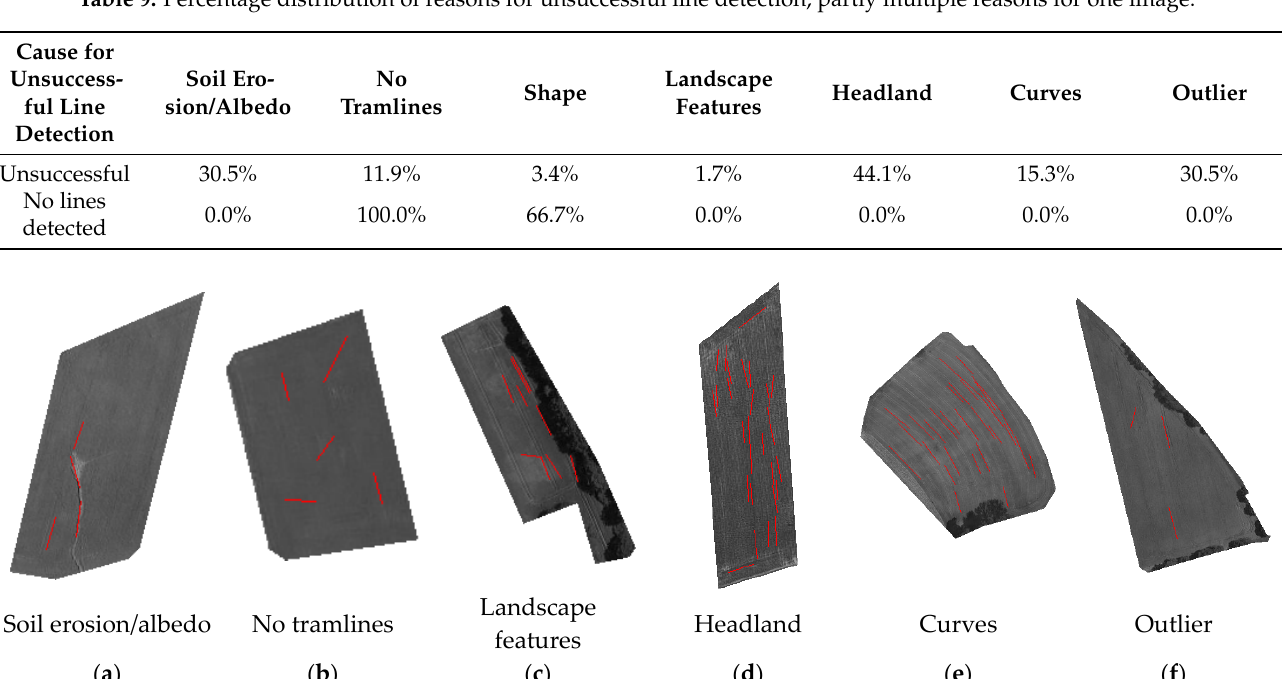
Figure 20. Examples of unsuccessful line detection and their different causes, except the category ‘unfavorable polygon shape’; lines detected by FLD in red color (figures do not have the same scale); data source: [40,41]. ( a ) Soil erosion/albedo, ( b ) No tramlines, ( c ) Landscape features, ( d ) Headland, ( e ) Curves, ( f ) Outlier